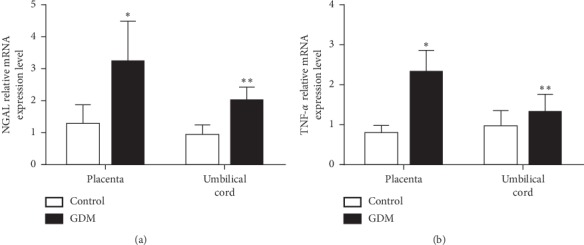
NGAL and TNF-α mRNA expression levels in placental tissues and umbilical cord blood samples of GDM and control groups. (a) Quantification of differences in NGAL mRNA expression levels between the two groups; ∗P=0.001, ∗∗P < 0.001. (b) Quantification of differences in TNF-α mRNA expression levels between the two groups; ∗P=0.001, ∗∗P=0.021. NGAL and TNF-α mRNA levels were corrected for the expression of the housekeeping gene, GAPDH.